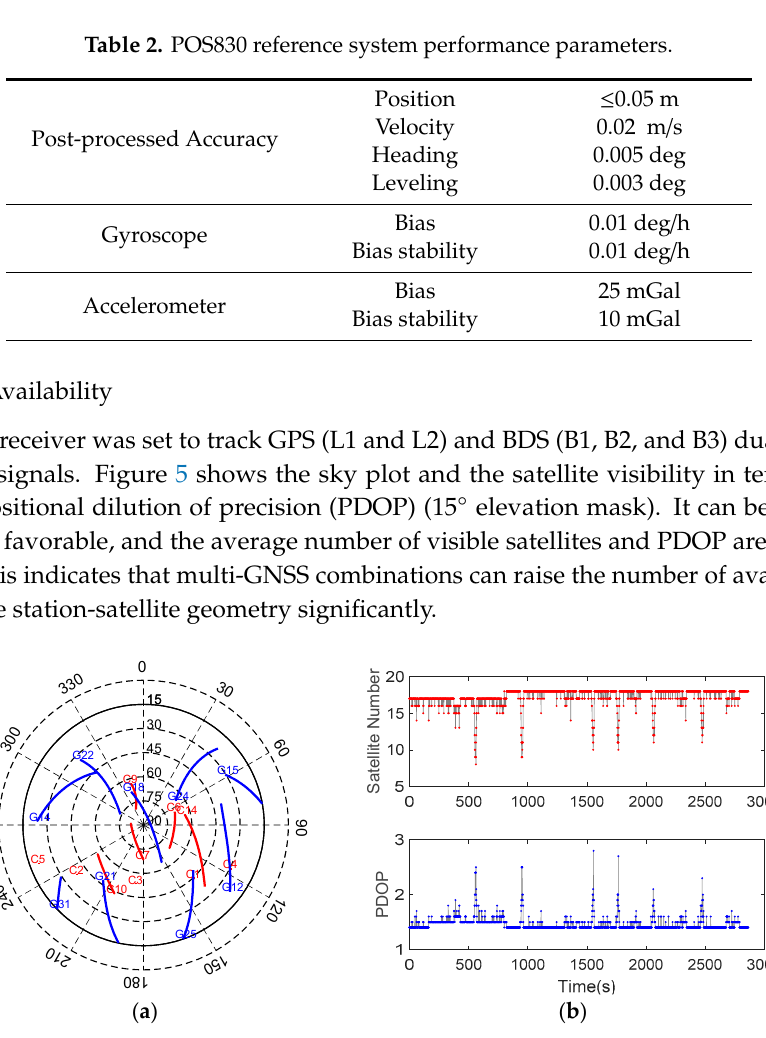
Figure 5. Sky plot ( a ) and the satellite visibility ( b ) for test #1.